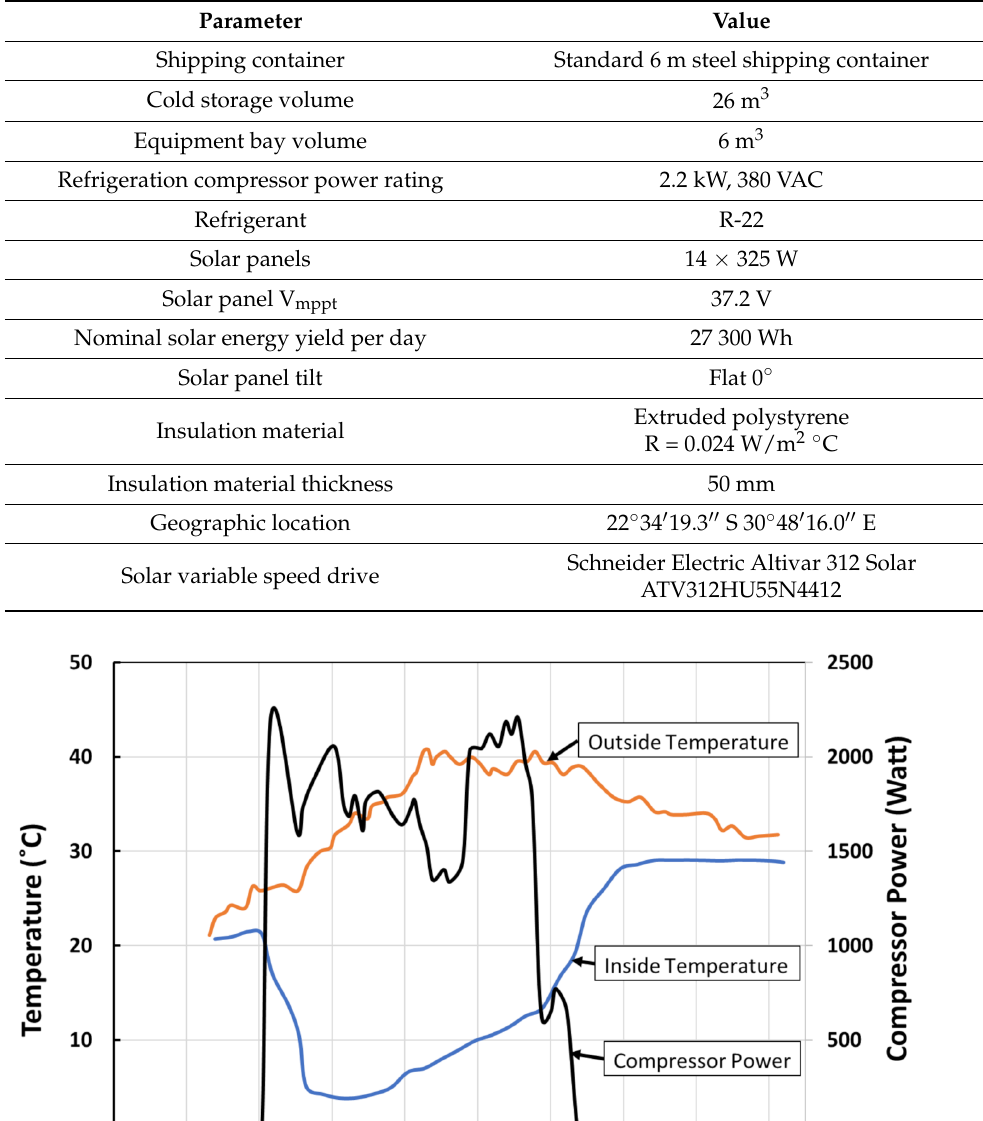
Table 1. Gwakwani cold storage parameters.